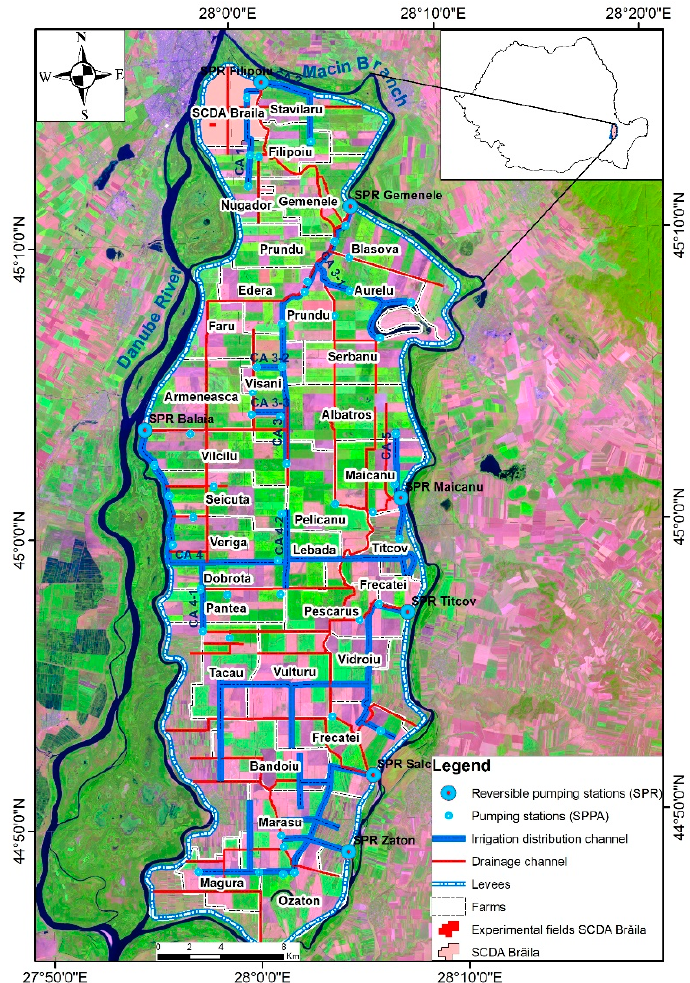
Figure 1. IMB Irrigation District, farms and infrastructure (levees/drainage/irrigation) location in the Embanked Great Island of Danube River, Br ă ila, Romania.